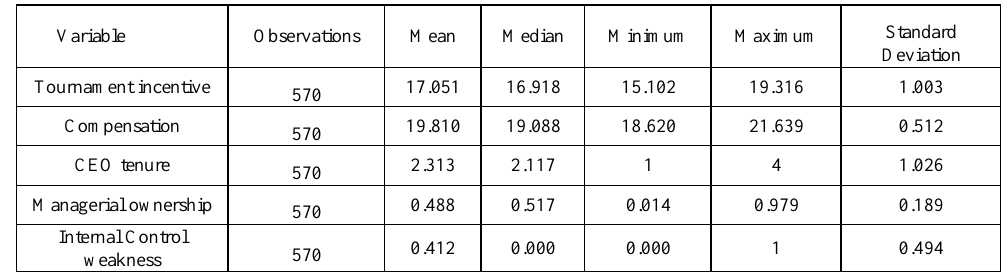
Table 1. Descriptive statistics of the research